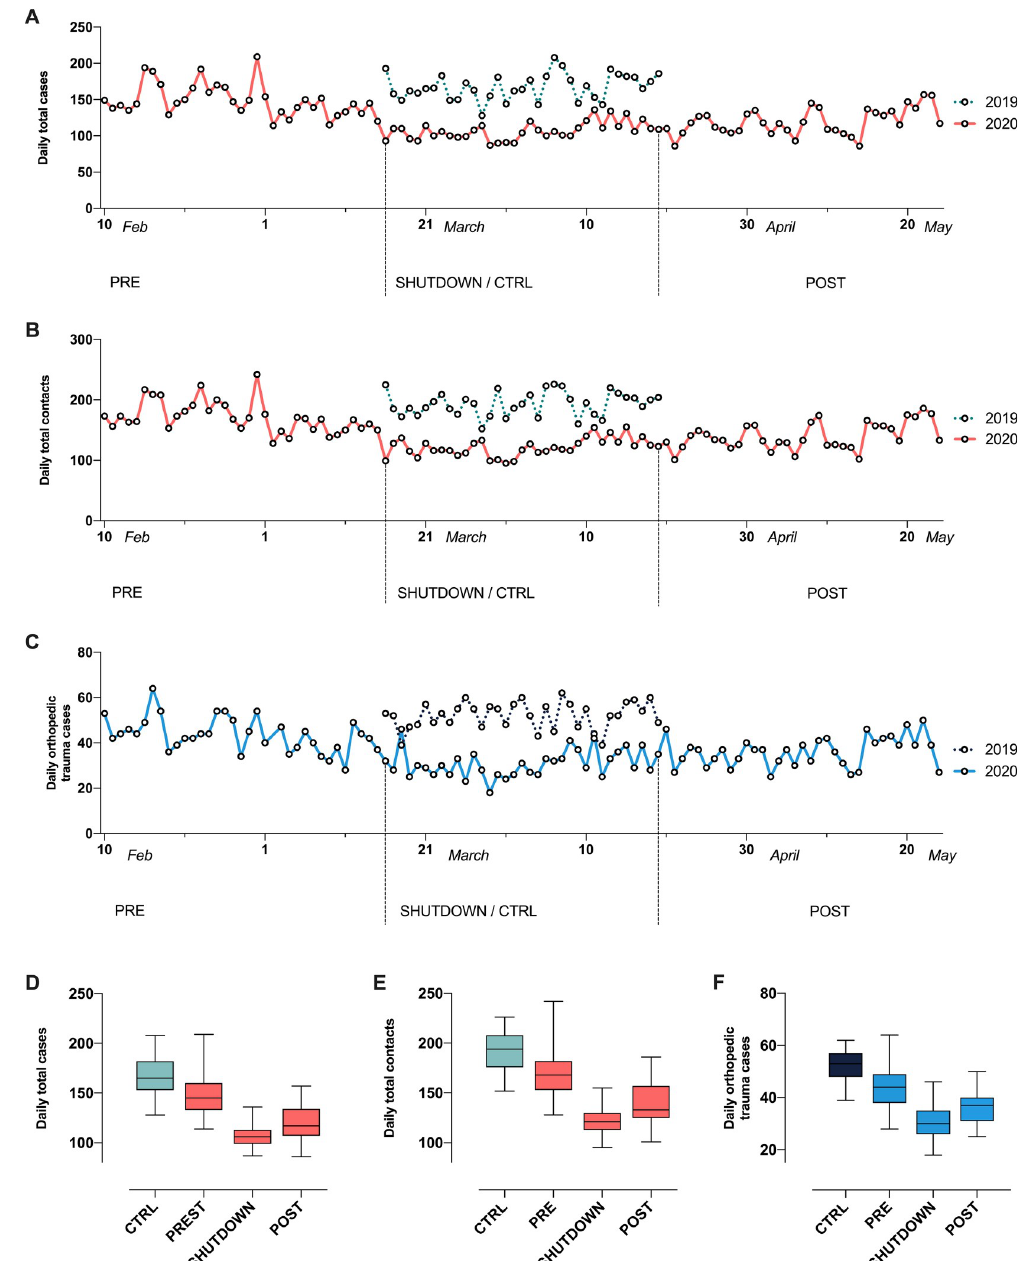
Fig 2. Daily total cases, contacts and orthopedic trauma cases before, during and after the COVID-19 shutdown. A–C: Number of daily (A) total cases, (B) total contacts and (C) orthopedic trauma cases day by day during the four defined periods. Dotted lines indicate the CTRL period in 2019, solid lines indicate PRE, SHUTDOWN and POST periods in 2020. D–F: Box-whisker plots show the number of daily (D) total cases, (E) total contacts and (F) orthopedic trauma cases during the four different periods. CTRL = control; PRE = pre shutdown transition; POST = post shutdown transition; SHUTDOWN =